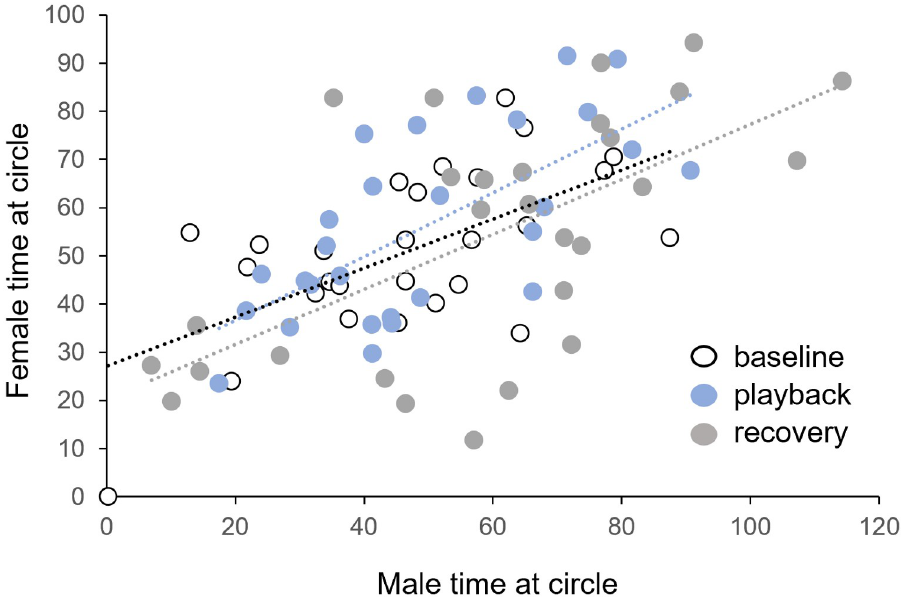
Fig 9. Correlation between male and female behavior. Although BBV playback does not alter male or female time spent at the circle, male and female time at the circle is correlated in the baseline period (white symbols), the playback period (blue circles), and the recovery period (gray circles). Dots represent individual trials including trials for all 3 exemplars (n = 28). Dashed lines indicate the linear regression for each